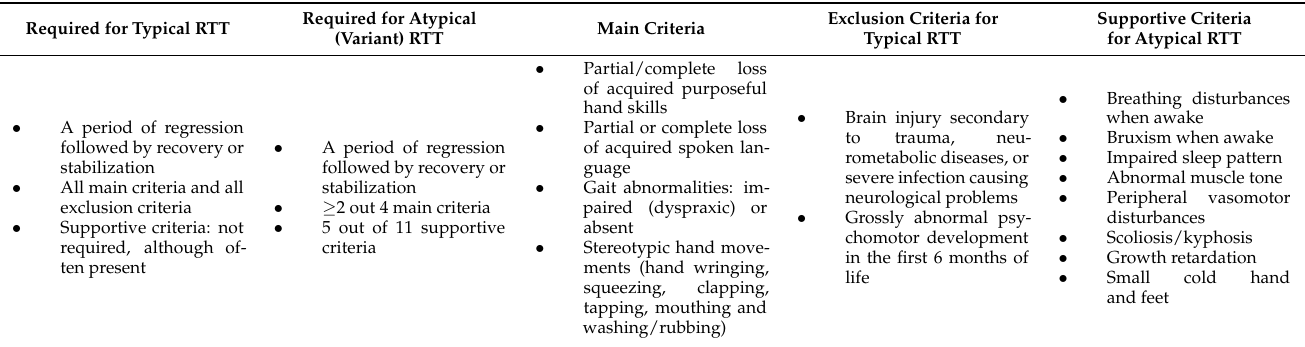
Table 1. Neul’s criteria for typical and atypical Rett